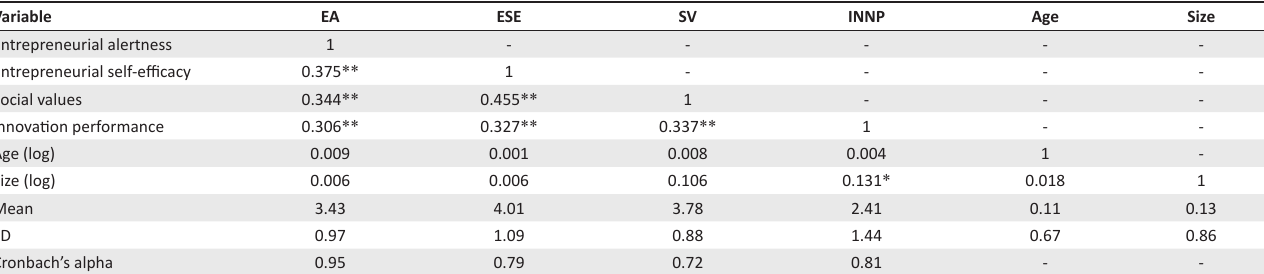
TABLE 2: Descriptive and correlation